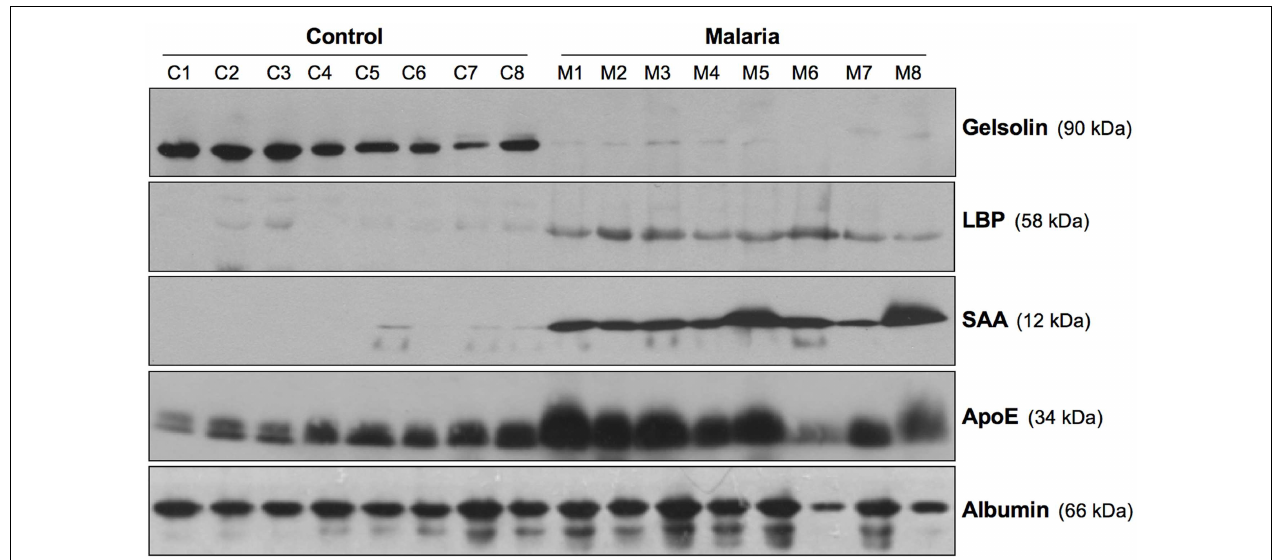
gelsolin, LPS-binding protein (LBP), serum amyloid A (SAA), apolipoprotein E (ApoE), and serum albumin. C1–C8, control; M1–M8, malaria. Figure was taken from the supplemental data of Ref.